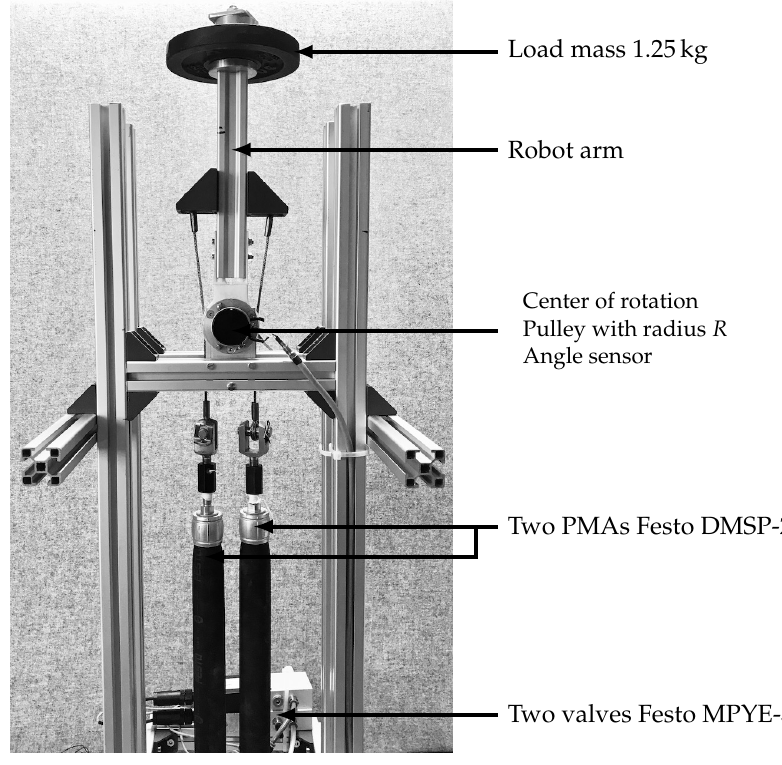
Figure 7. Robot arm with 1-DOF